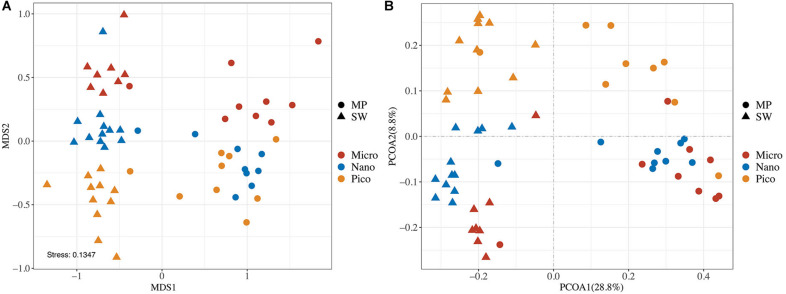
Plots of non-metric multidimensional scaling (nMDS) ordination based on Bray Curtis dissimilarities (A) and Unweighted UniFrac principal coordinates analysis (PCoA; B) of microbial eukaryotes based on community distance matrices.